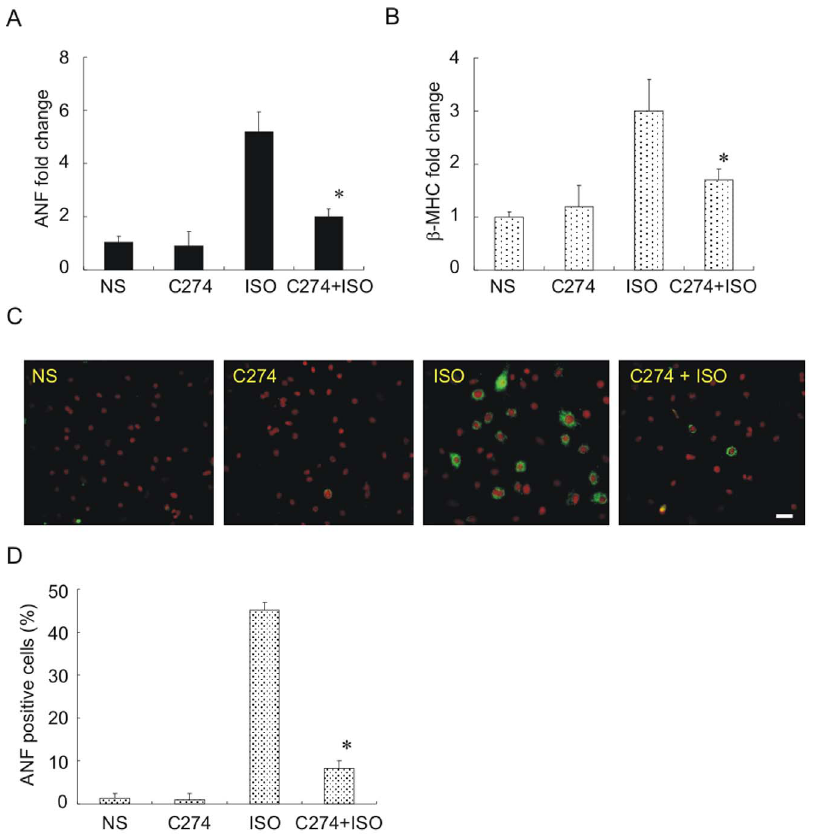
Figure 1. Isoproterenol-induced fetal gene upregulation is blunted by CpG-ODN in NRVMs. (A, B) induction of ANF (A) and b -MHC (B) mRNAs by isoproterenol as measured by qPCR assays and its blockade by pre-treatment with C274 ( n =4, * p , 0.01 versus isoproterenol group). NRVMs were pre-treated with C274 (5 m g/ml) for 12 h followed by isoproterenol (10 m M 6 48 h). 18-S rRNA was used as an internal standard. The mean normalized value for expression of each gene in unstimulated cells is defined as 1. (C) the number of isoproterenol-induced ANF-expressing cells was reduced by C274 pre-incubation. For indirect immunofluorescence cells were first incubated with anti-ANF antibody followed by reaction with Alexa-488 conjugated second antibody ( green ). Propidium iodide (PI) was used as counterstain for nuclei ( red ). Scale bar=20 m m. (D) quantitative analysis of ANF positive cells as shown in (C) ( n =4 throughout the groups, * p , 0.01 versus isoproterenol group). For each experiment at least 50 cells were counted randomly using